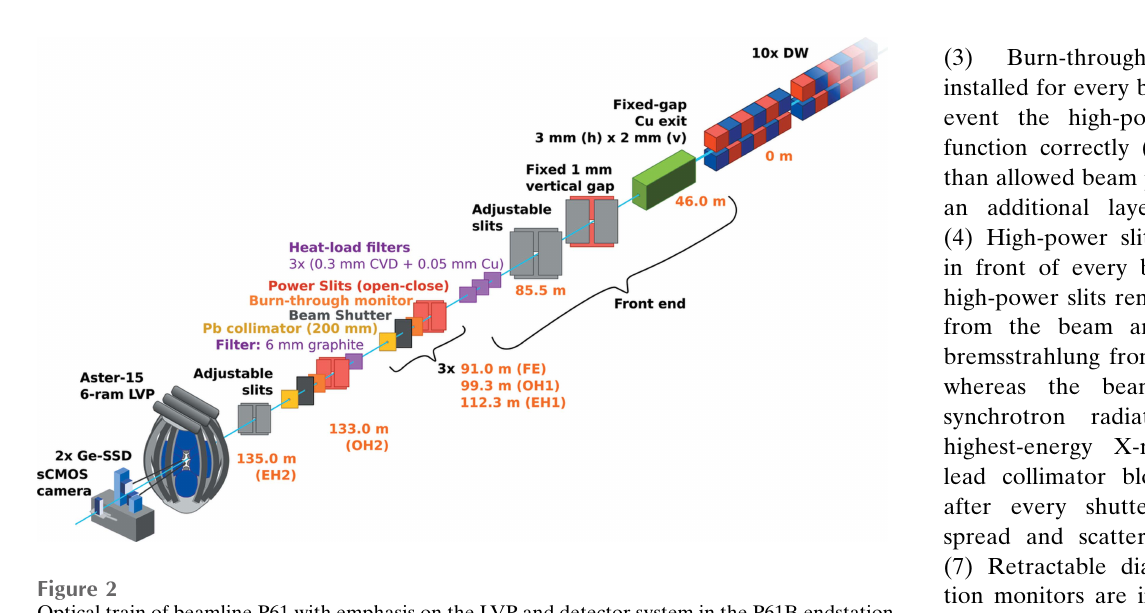
Figure 2 Optical train of beamline P61 with emphasis on the LVP and detector system in the P61B endstation. The optics shown in the brackets are repeated three times in the front end (FE), optics hutch 1 (OH1) and experimental hutch 1 (EH1). In OH2, an additional filter is installed (4 mm graphite). Two slit systems are user-controlled: PS2 in the FE and PS6 in EH2 (P61B). For regular operation, there is always at least one heat-load filter inserted to avoid overheating the beamline components and to reduce the low-energy radiation and production of ozone, both harmful to instrumentation.